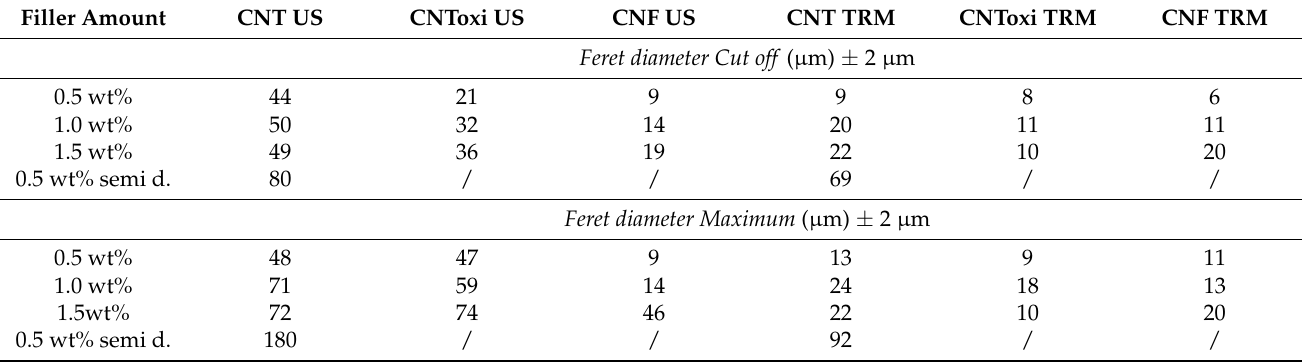
Table 3. Result of the Feret diameter evaluation: cut-off and maximum for different nanofillers and dispersion methods. Filler Amount